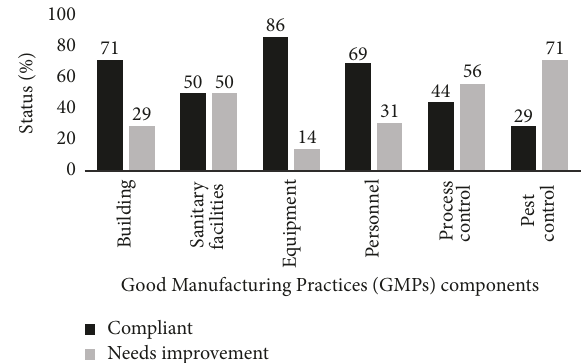
Figure 3: Overall level of compliance to GMPs in OFSP puree processing plant; the values above the bars represent the mean percentage score for compliance/noncompliance to